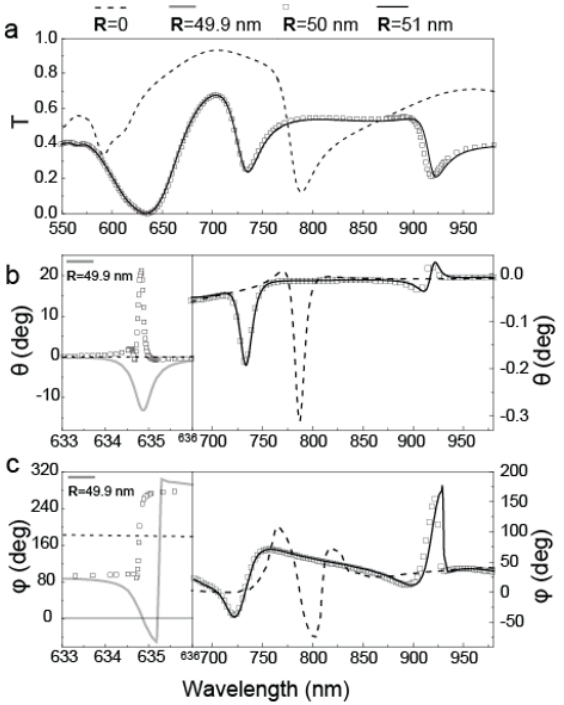
Fig. 1. a) Calculated transmittance (b) polarization rotation spectra and (b) phase shift between the E x and E y components for a nested 2D structure with D 1 = 350 nm. The pairs of spectra demonstrate their dependence on a negligible change of R . Spectra of the square 2D structure with D 1 = 350 nm are shown for